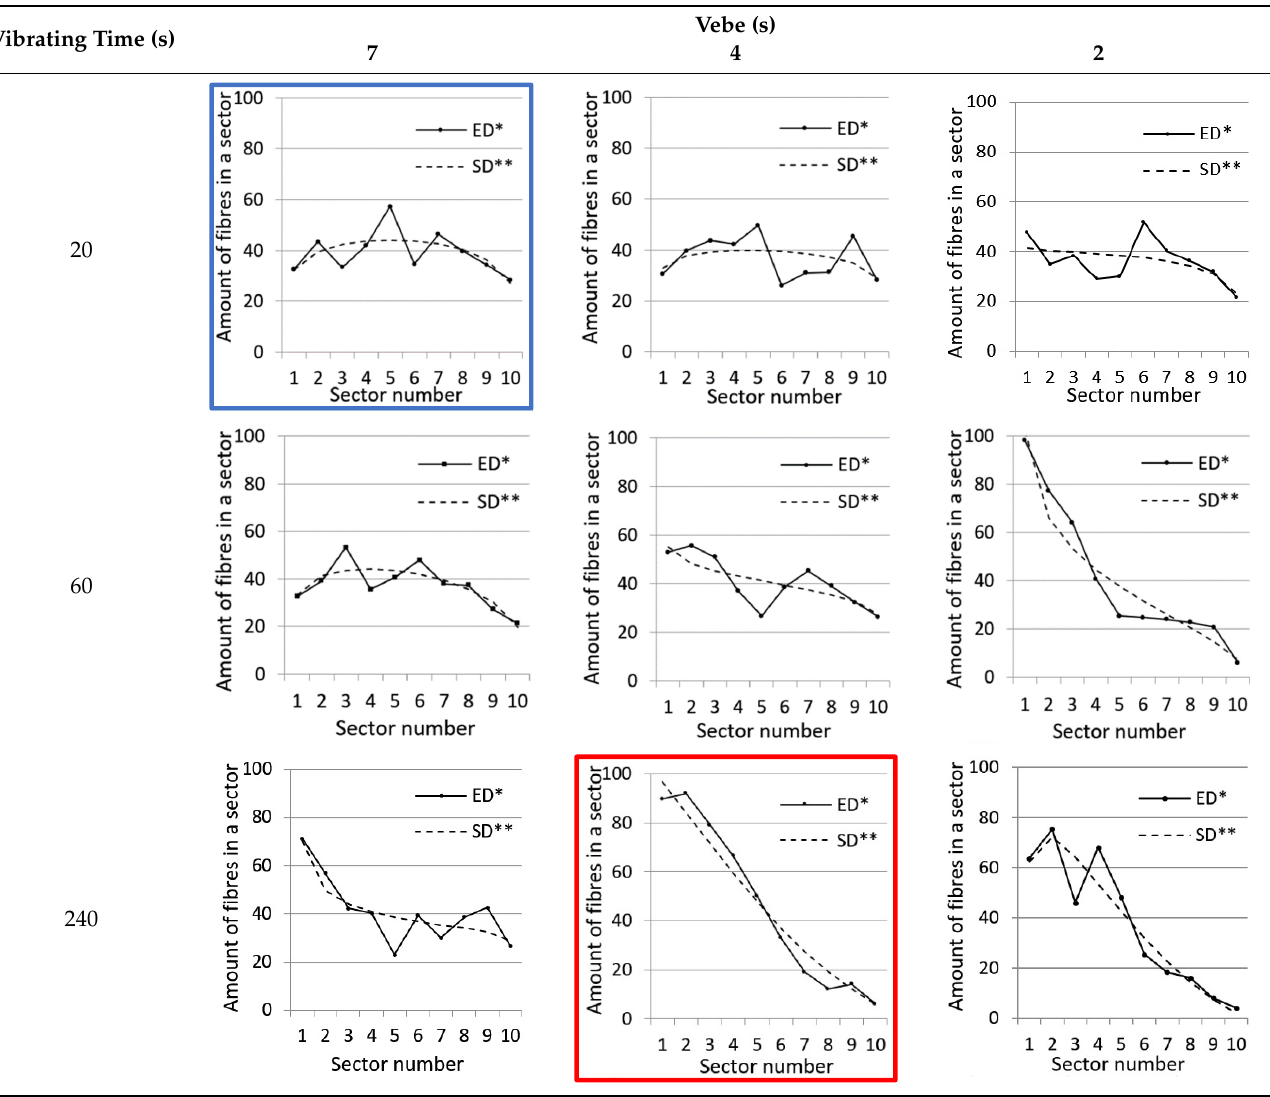
Table 5. Experimentally tested distribution of fibres (ED*) along the height of the specimens and calculated statistical distribution using the GT-Kw distribution